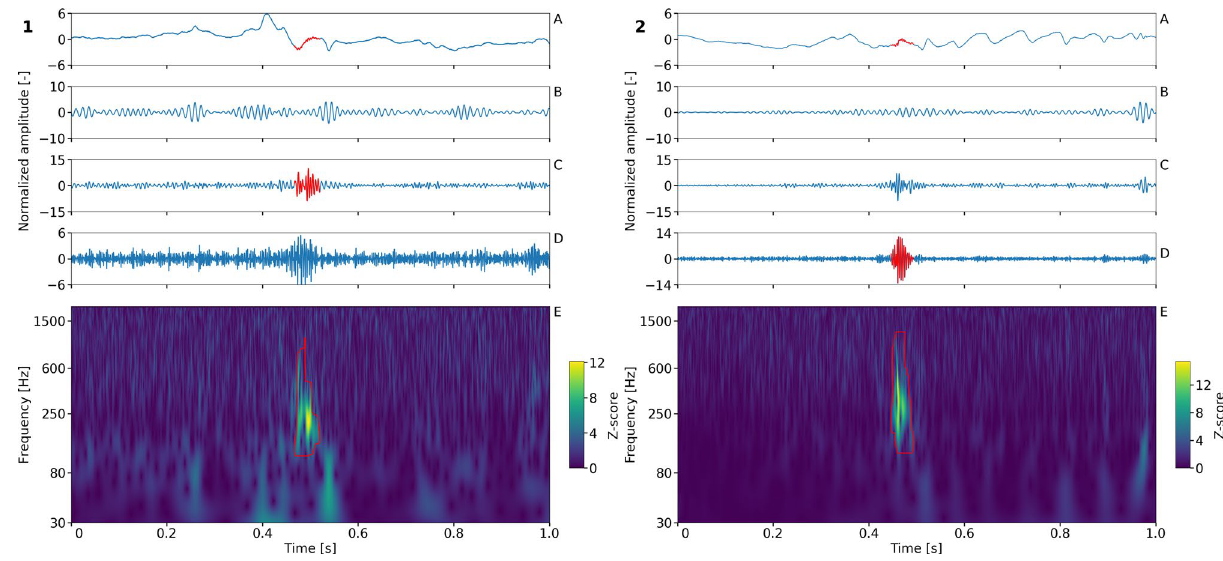
Figure 1. HFO detection. Raw data (A) and band-pass filtered data in the high gamma band frequency (65– 80 Hz; (B), ripple band (80–250 Hz; (C) and fast ripple band (250–600 Hz; (D,E) Z-scored power envelopes in a series of log spaced band-pass filtered bands. The time scale of all subplots (A–E) is identical. The detection is represented by red lines in (A,C,E). The brightest spot of the detected event in (E) corresponds to the maximum peak relative amplitude. The frequency of the event is determined by the frequency band in which this peak occurred. The duration of the event is calculated as the difference between earliest onset and latest offset across frequency bands.